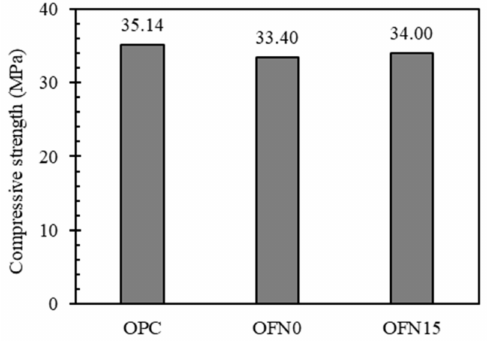
Figure 5. Compressive strength of concrete.